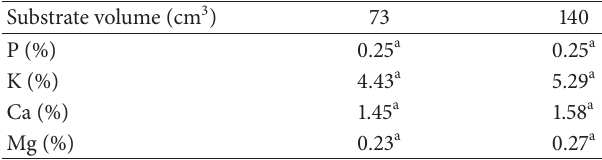
Table 5: Effect of substrate volumes on phosphorus, potassium, calcium, and magnesium level in leaves of chrysanthemum at 14 weeks after